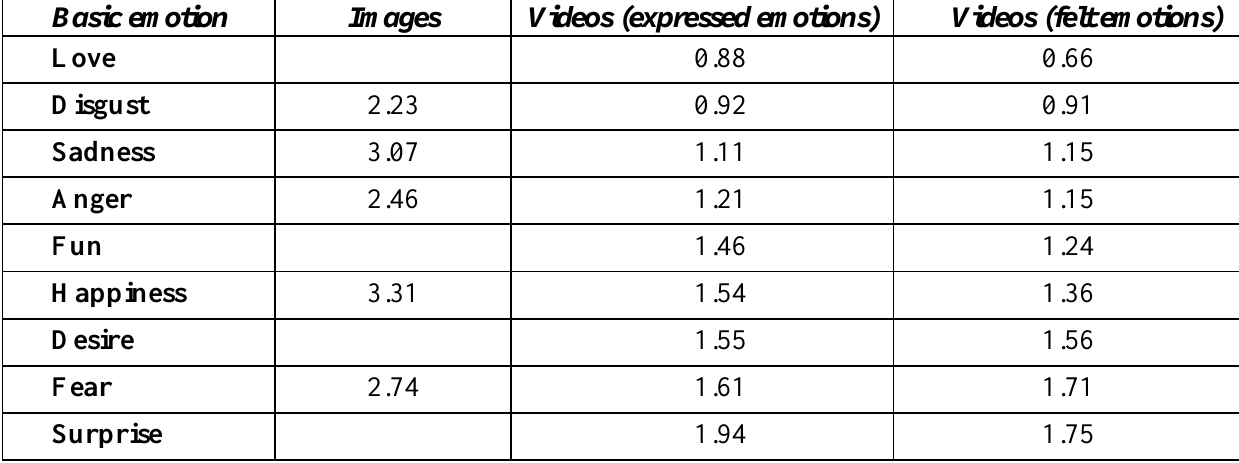
Table 1. Consistency of emotional voting (standard